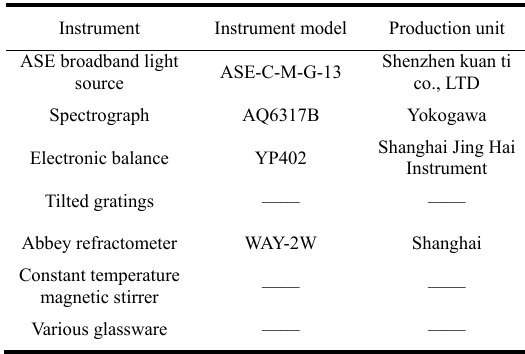
Table 1 Equipmental list.